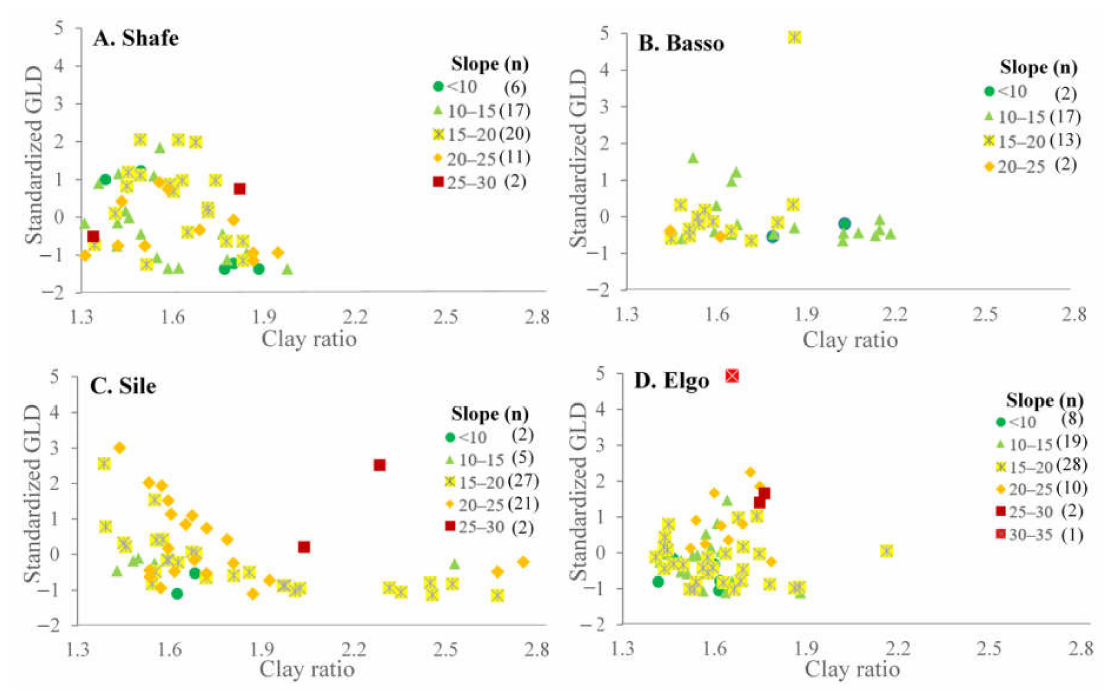
Figure A3. Relationships between GLD with clay ratio of the soil and slope angle for each sub- catchment of the four study catchments. Clay ratio is % (sand + silt)/% (clay). Slope represents the mean slope angle (degree) of each sub-catchment and n represents the number of sub-catchments for each slope-angle class.